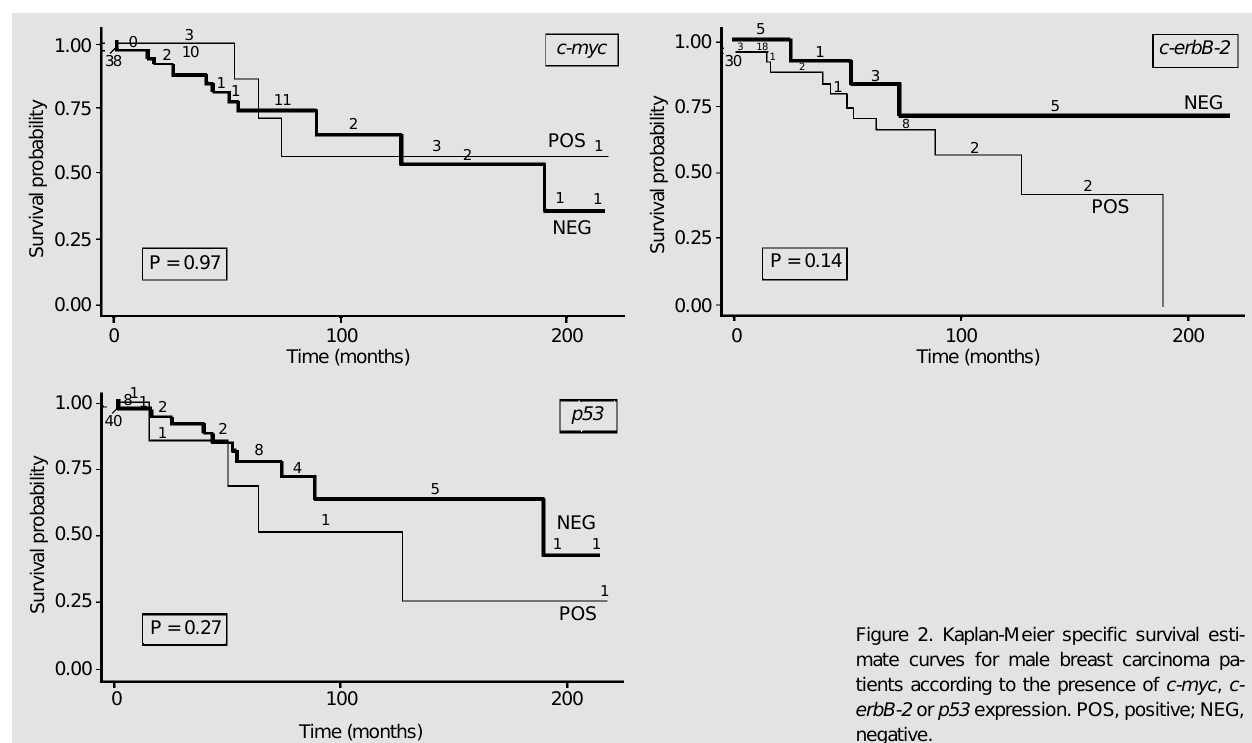
Figure 2. Kaplan-Meier specific survival esti- mate curves for male breast carcinoma pa- tients according to the presence of c-myc , c- erbB-2 or p53 expression. POS, positive; NEG,